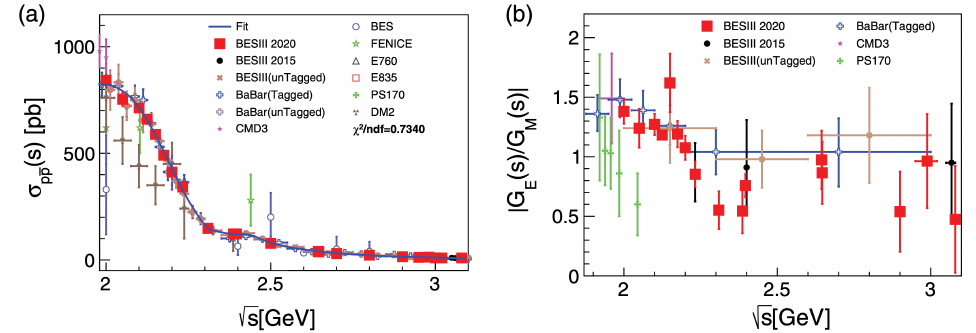
Figure 2: BESIII results for the cross section of e + e − → pp (red solid squares), panel / G | of the proton, panel (b) [ 5 ] (a), and the ratio | G E M